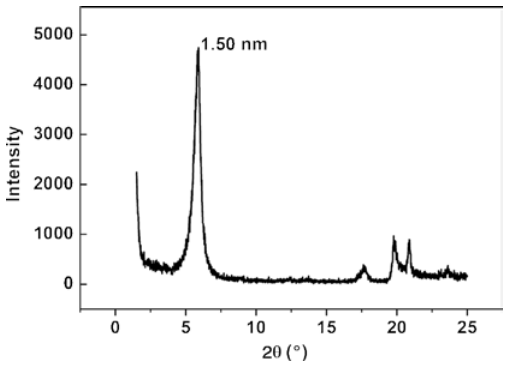
Figure 1: XRD patterns of